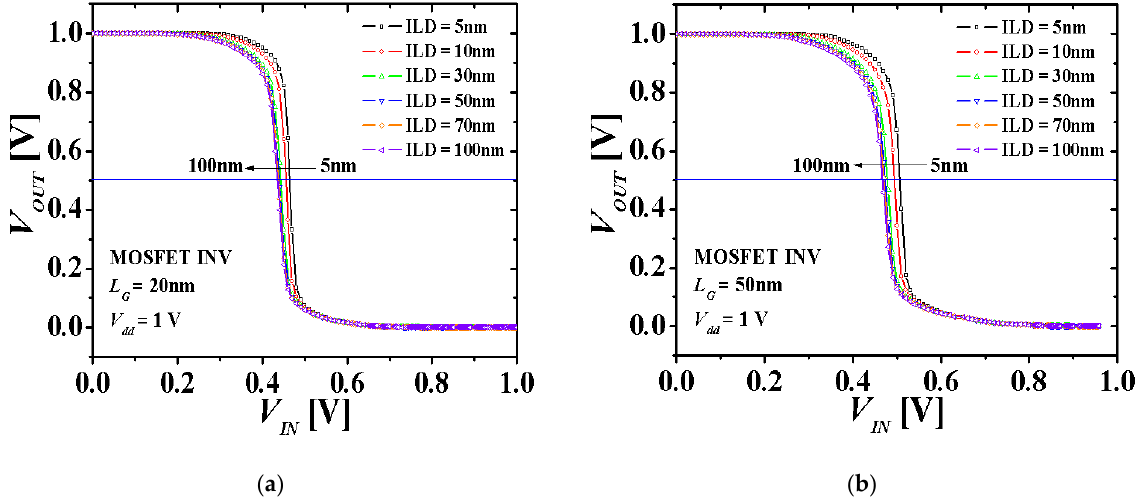
Figure 5. Voltage transfer characteristics of M3INV-MOS cell with ( a ) L G = 20 nm and ( b ) L G = 50 nm. V dd (=1 V) is DC-biased.